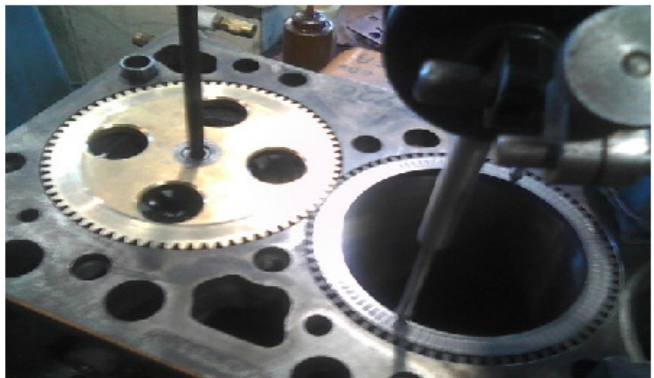
Figure 4. Block of the RLE diesel prototype. The driving gear could be replaced by another rotating liner, so the engine could operate as a complete four-cylinder 4BT RLE.